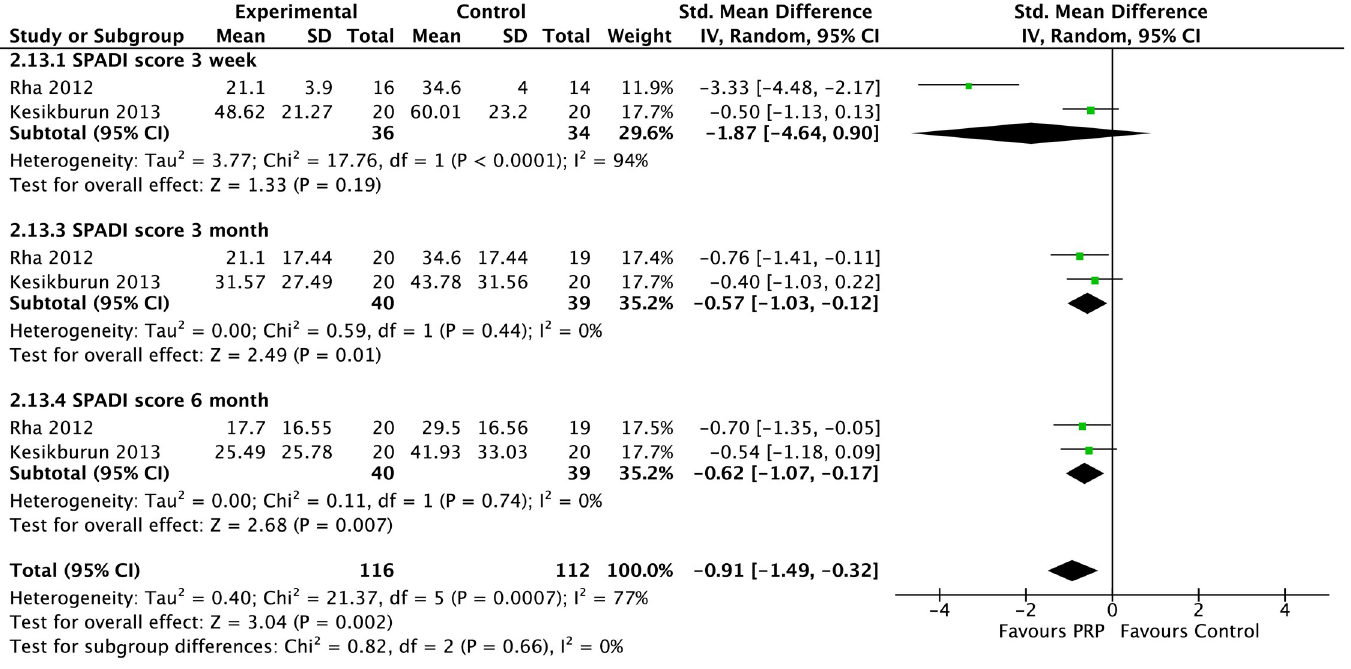
Fig 5. Forest plot on SPADI shoulder pain scores based on follow-up periods.